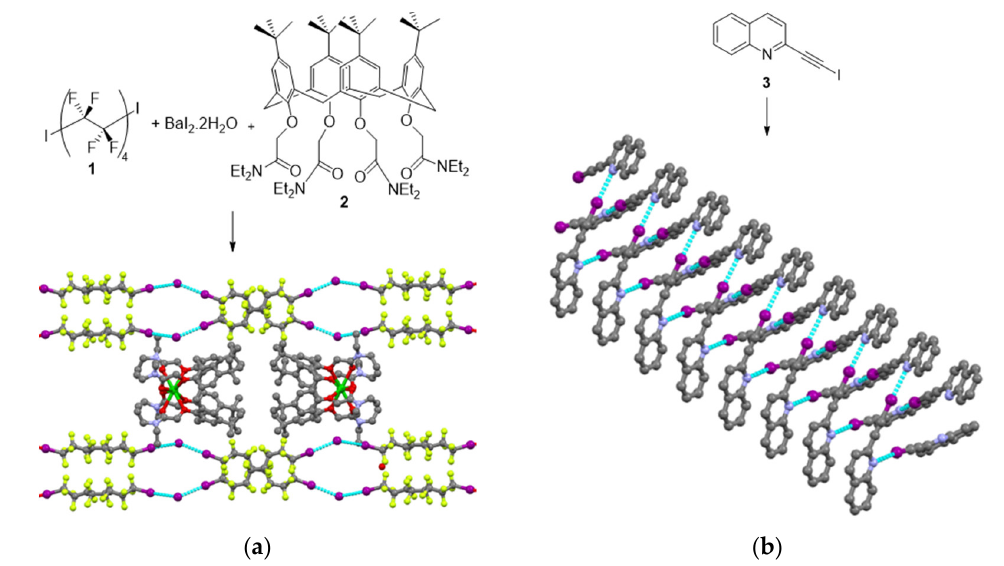
Figure 2. Representative examples of spontaneous resolution (XB is represented by blue dash lines): ( a ) Crystal structure of the chiral double helical structure formed by mixing 1 , 2 and BaI 2. 2H 2 O; ( b ) Crystal structure of the right-handed helix obtained by self-assembly of 3 (Reprinted/adapted with permission from Ref [37]. Copyright 2009, Wiley and from Ref [39]. Copyright 2018, Wiley).